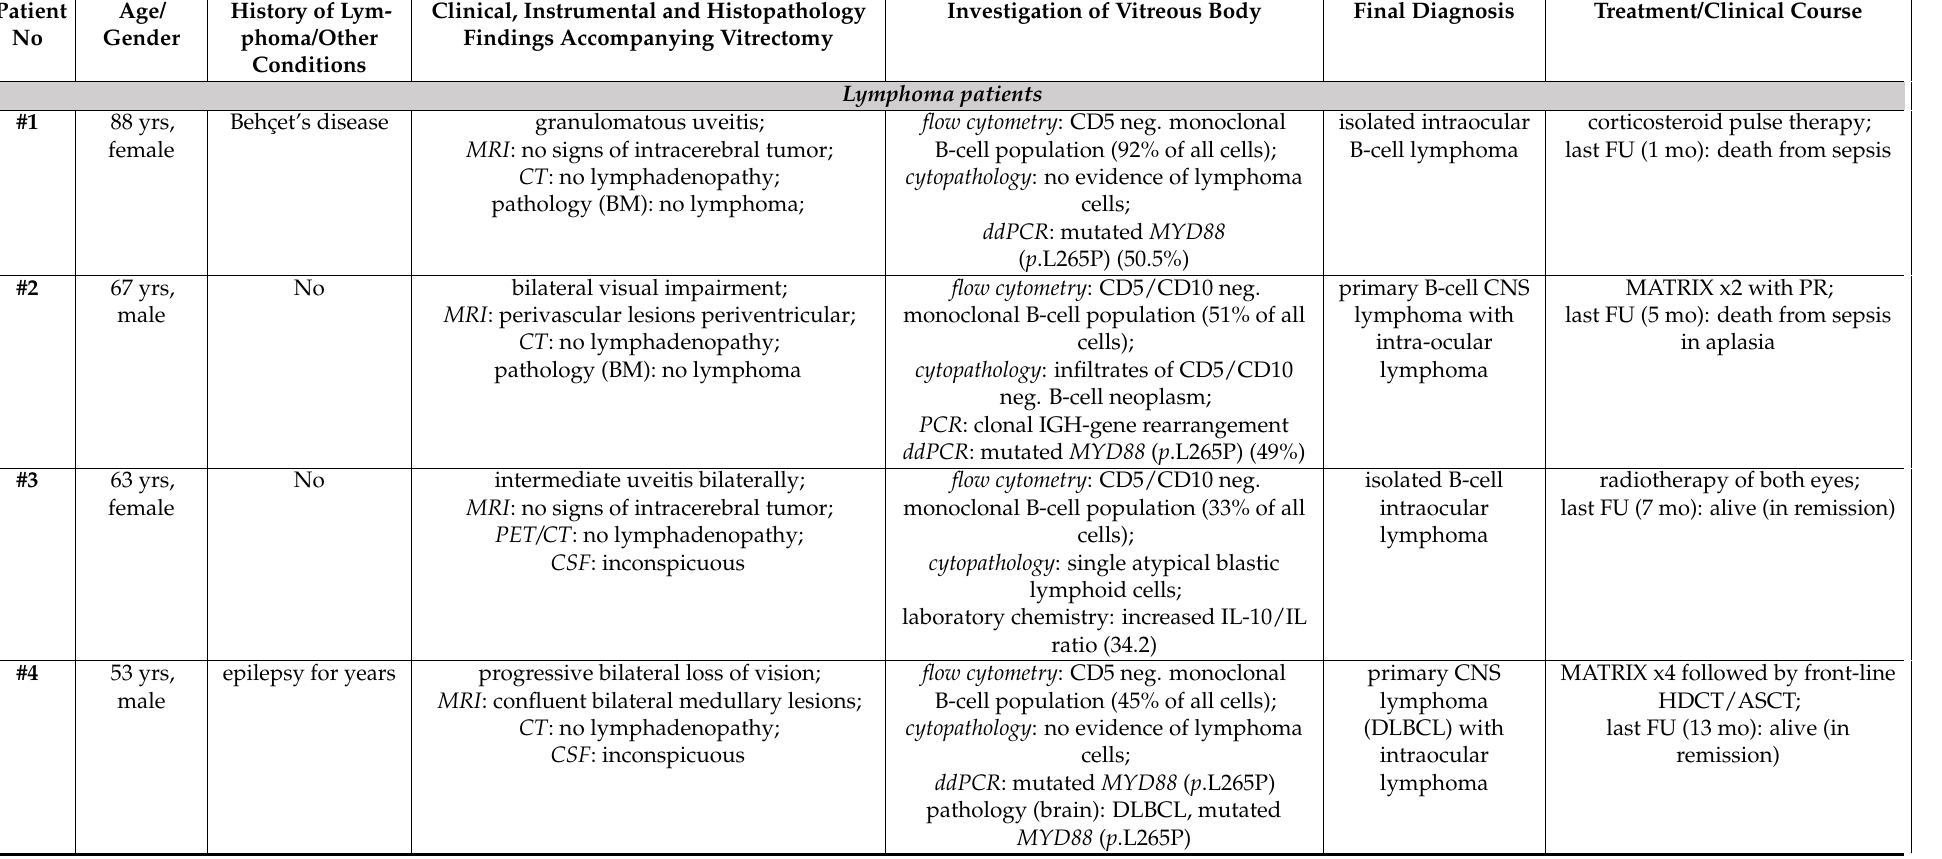
Table 1. Overview on seven patients with confirmed or excluded intraocular lymphoma. Yrs, years; DLBCL, diffuse large B-cell lymphoma; R-CHOP, rituximab, cyclophosphamide, daunorubicin, vincristine, prednisone; PR, partial remission; CSF: cerebrospinal fluid; MRI, magnetic resonance imaging; CNS, central nervous system; MTX, methotrexate; FU, follow-up; mo., month(s); CT, computed tomography; BM, bone marrow; neg, negative; ddPCR, digital droplet polymerase chain reaction; IGH, immunoglobulin heavy locus; MATRIX, methotrexate, cytarabine, thiotepa, rituximab; HDCT/ASCT, high-dose chemotherapy/autologous stem cell transplantation; PET, positron emission